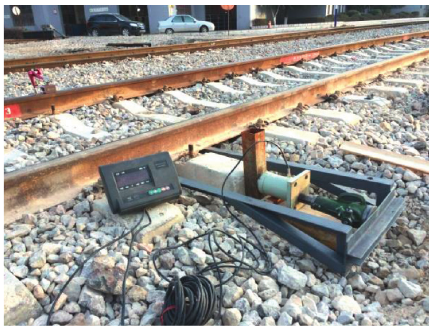
Figure 6: Lateral resistance test of